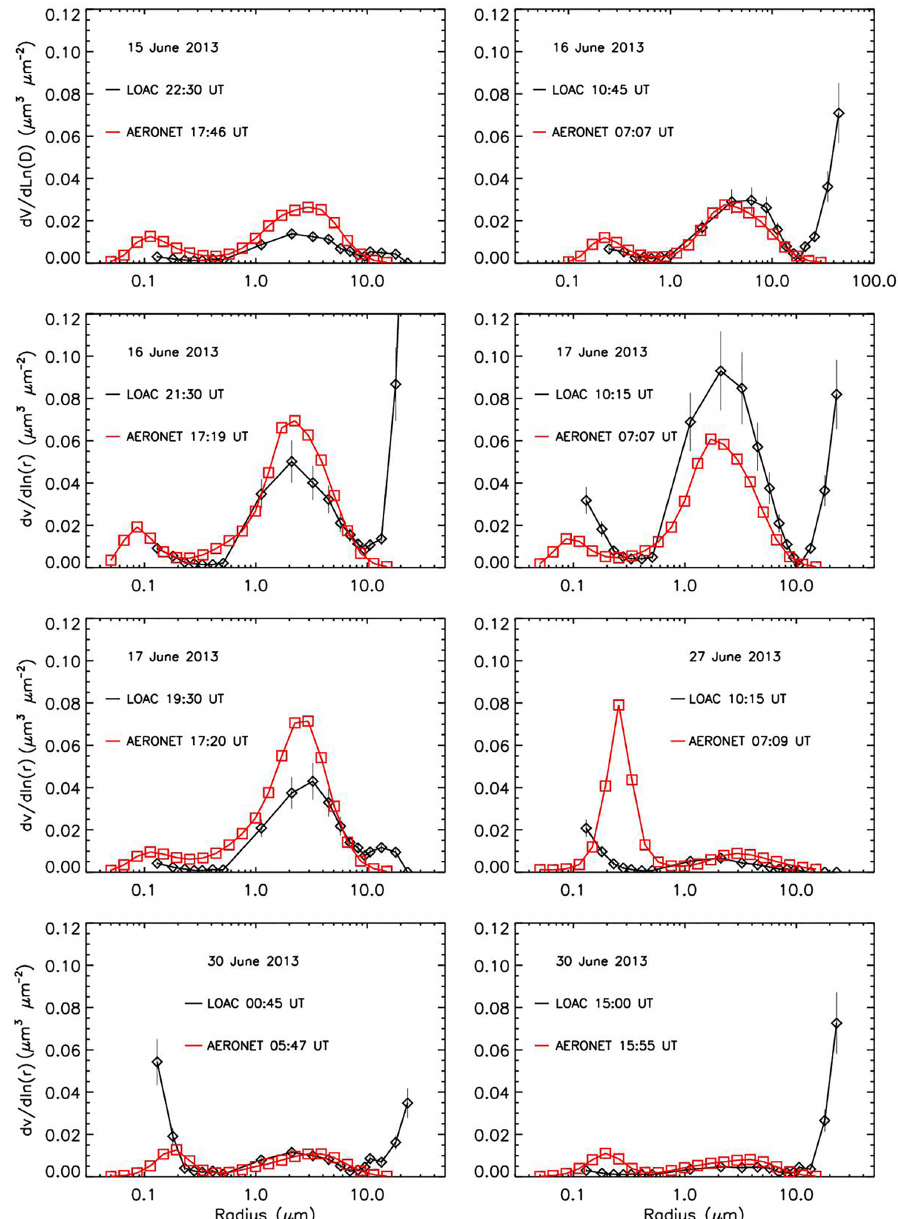
Figure 13. Volume size distribution retrieved from AERONET (https://aeronet.gsfc.nasa.gov/) and LOAC data on Minorca during the June 2013 plume